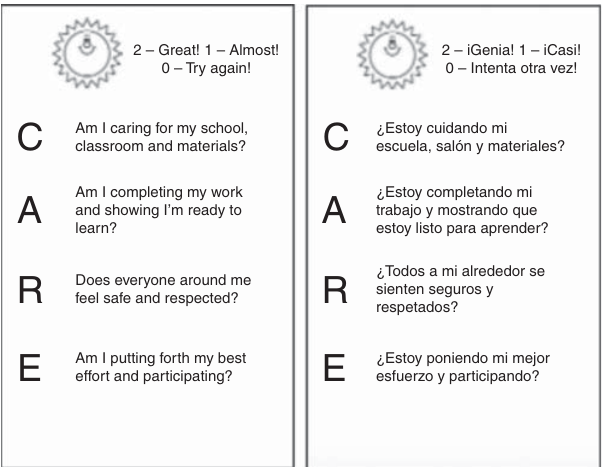
Figure 1. Check-in, check-out reflection